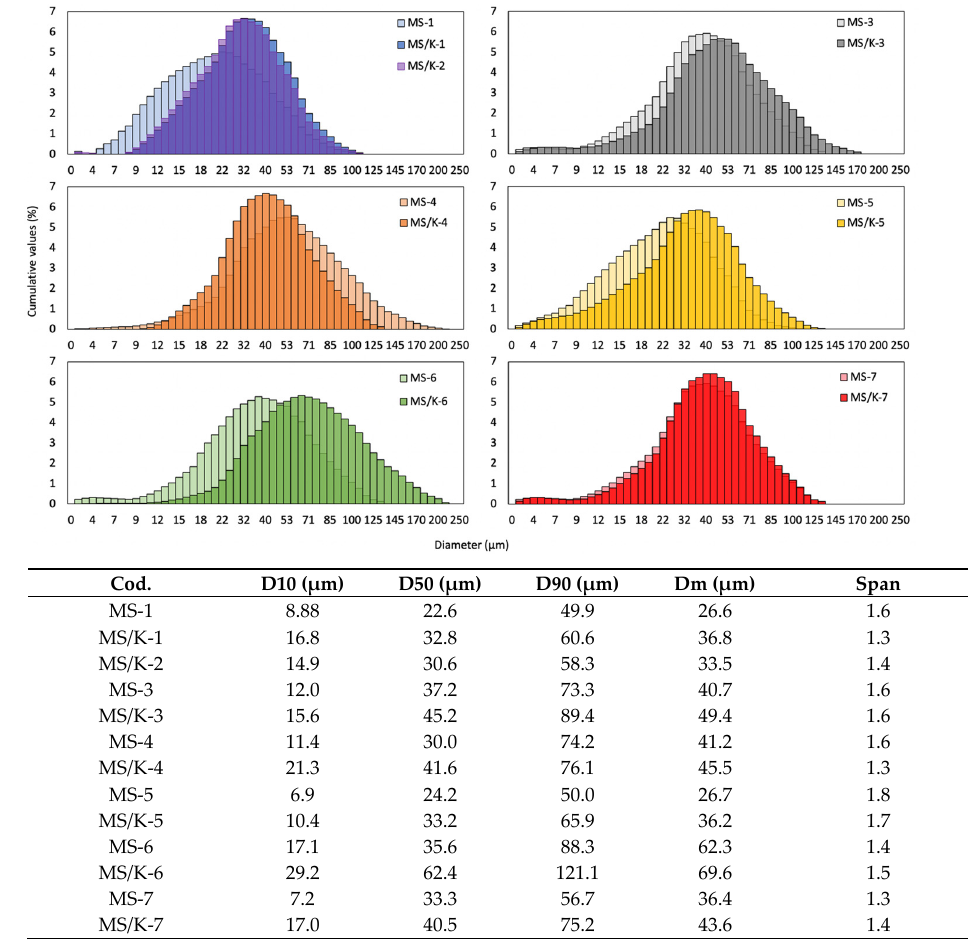
Figure 5. Effects of synthesis parameters on MS diameter distribution. The typical diameter distribution curve is reported in the exemplary graph. The values of the average diameter (D M —the diameters for which 90% (D90), 50% (D50), and 10% (D10) of the particles were below each value) and the span index are reported in the table.